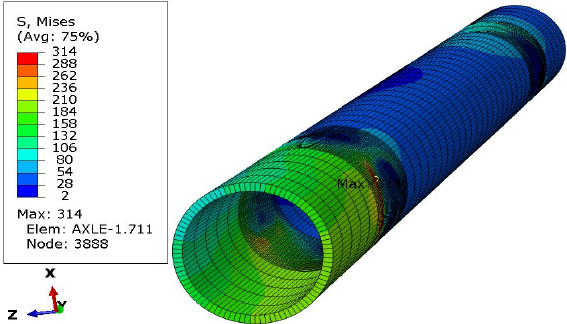
Figure 7. Stress distribution in the axle while both wheels loaded with 𝐹 (cid:2869)(cid:2929)(cid:2919)(cid:2914)(cid:2915) force.